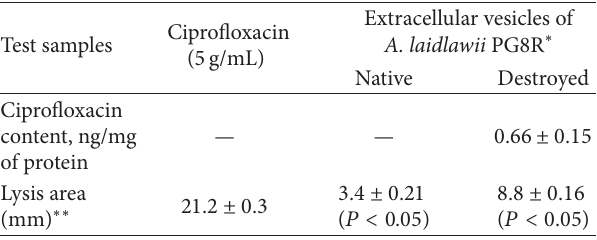
Figure 3: Results of the alignments of the nucleotide (a) and amino acid (b) sequences of the parC gene of Acholeplasma laidlawii PG8 cells (1), cells of A. laidlawii PG8R (2), and the extracellular vesicles of A. laidlawii PG8R (3). Italics indicate the sequences of the forward and reverse primers. Nucleotide substitutions and amino acid replacements are enclosed in rectangles, the active site. Table 1: Ciprofloxacin content and bacteriostatic activities of the extracellular vesicles of Acholeplasma laidlawii